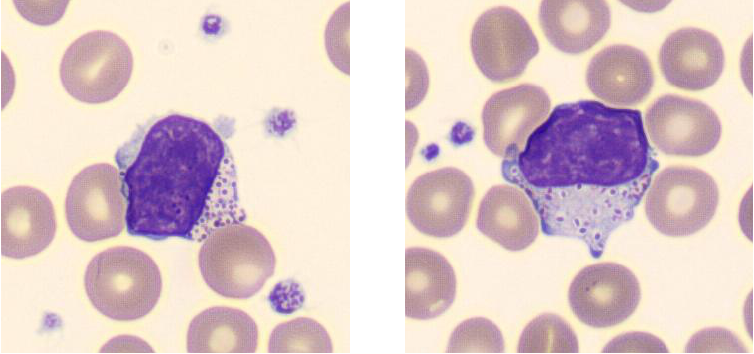
Figure 1. Patient’s peripheral blood lymphocytes showing Alder-like cytoplasmic inclusions (magnification ×100).